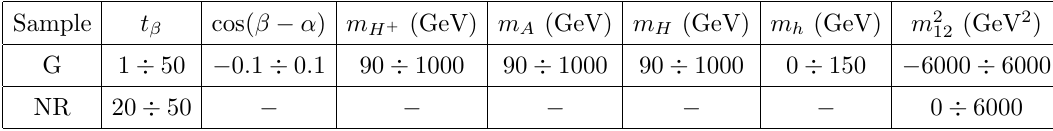
Table 1 . Input parameter ranges for the general sample (G) and non-regular points (NR). The dash denotes the same range as in the previous